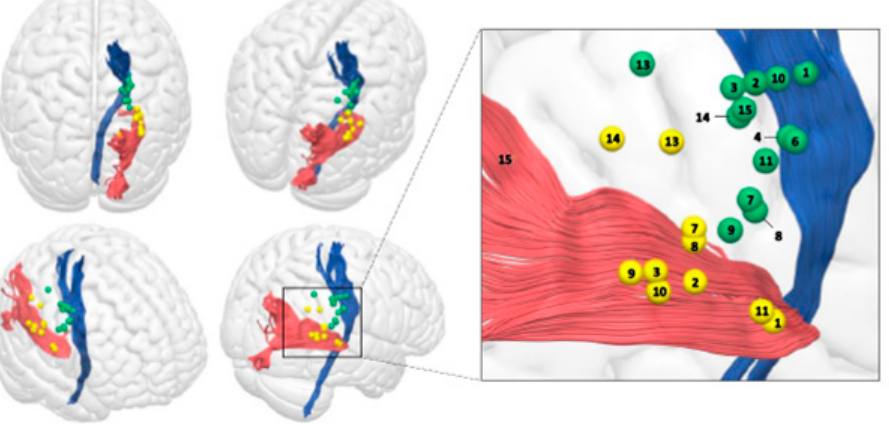
Figure 3. Schematic representation of the positive subcortical positive responses for optic radiations and corticospinal tract. Each number corresponds to the number ID of the patient in Table 1. Blue : Corticospinal tract. Red : Optic Radiations. Yellow spheres : Positive subcortical responses for optic radiations with high frequency bipolar stimulation. Green spheres : Positive subcortical responses for the corticospinal tract with high frequency monopolar